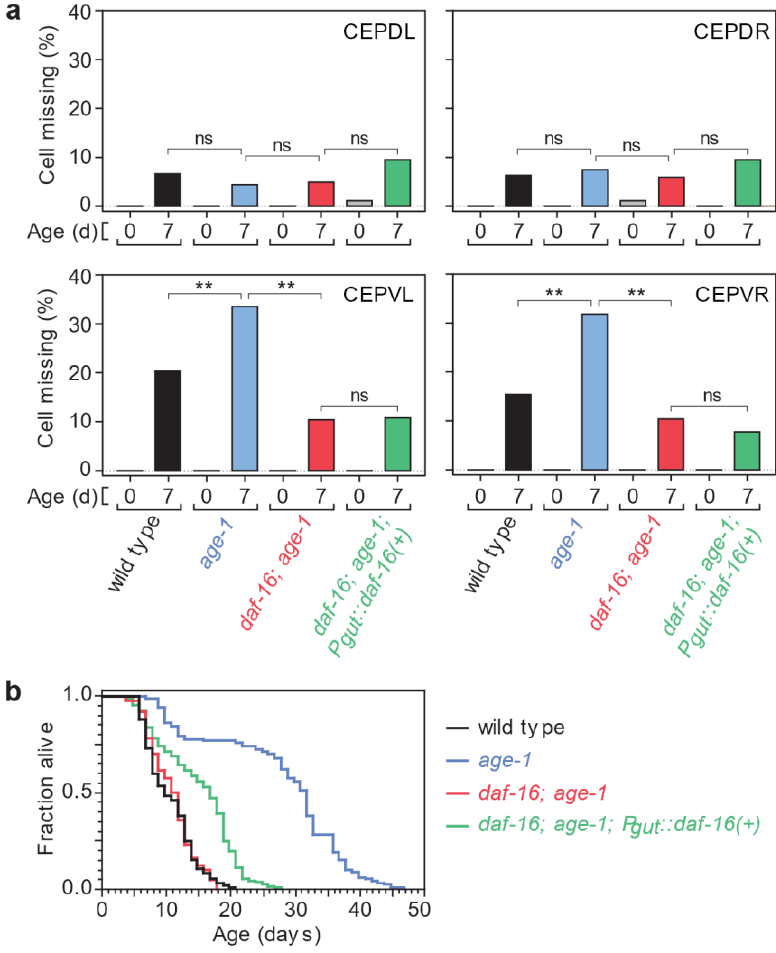
Figure 4. Effect of insulin/IGF1 signaling on neurodegeneration and lifespan. ( a ) Each panel shows the percentage of animals with the indicated cephalic neuron missing in young adults (day 0) and old adults (day 7). These percentages are paired for each specified genotype. Except for age-1 (CEPDL) and daf-16 ; age-1 (CEPDL and CEPDR), all pairs show a statistically significant difference of at least p = 0.004 between young and old. The double asterisk (**) indicates p ≤ 0.001; “ns” indicates that no significant difference was observed ( p > 0.05). For additional statistics see Table S3; ( b ) Survival curves for wild-type and mutant animals expressing α -synuclein in the dopaminergic neurons (Parkinson’s disease model). For statistics see Table S3.